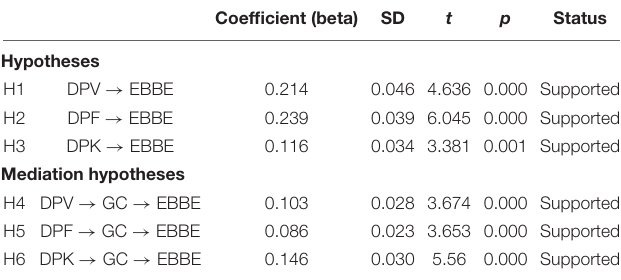
TABLE 5 | Hypotheses